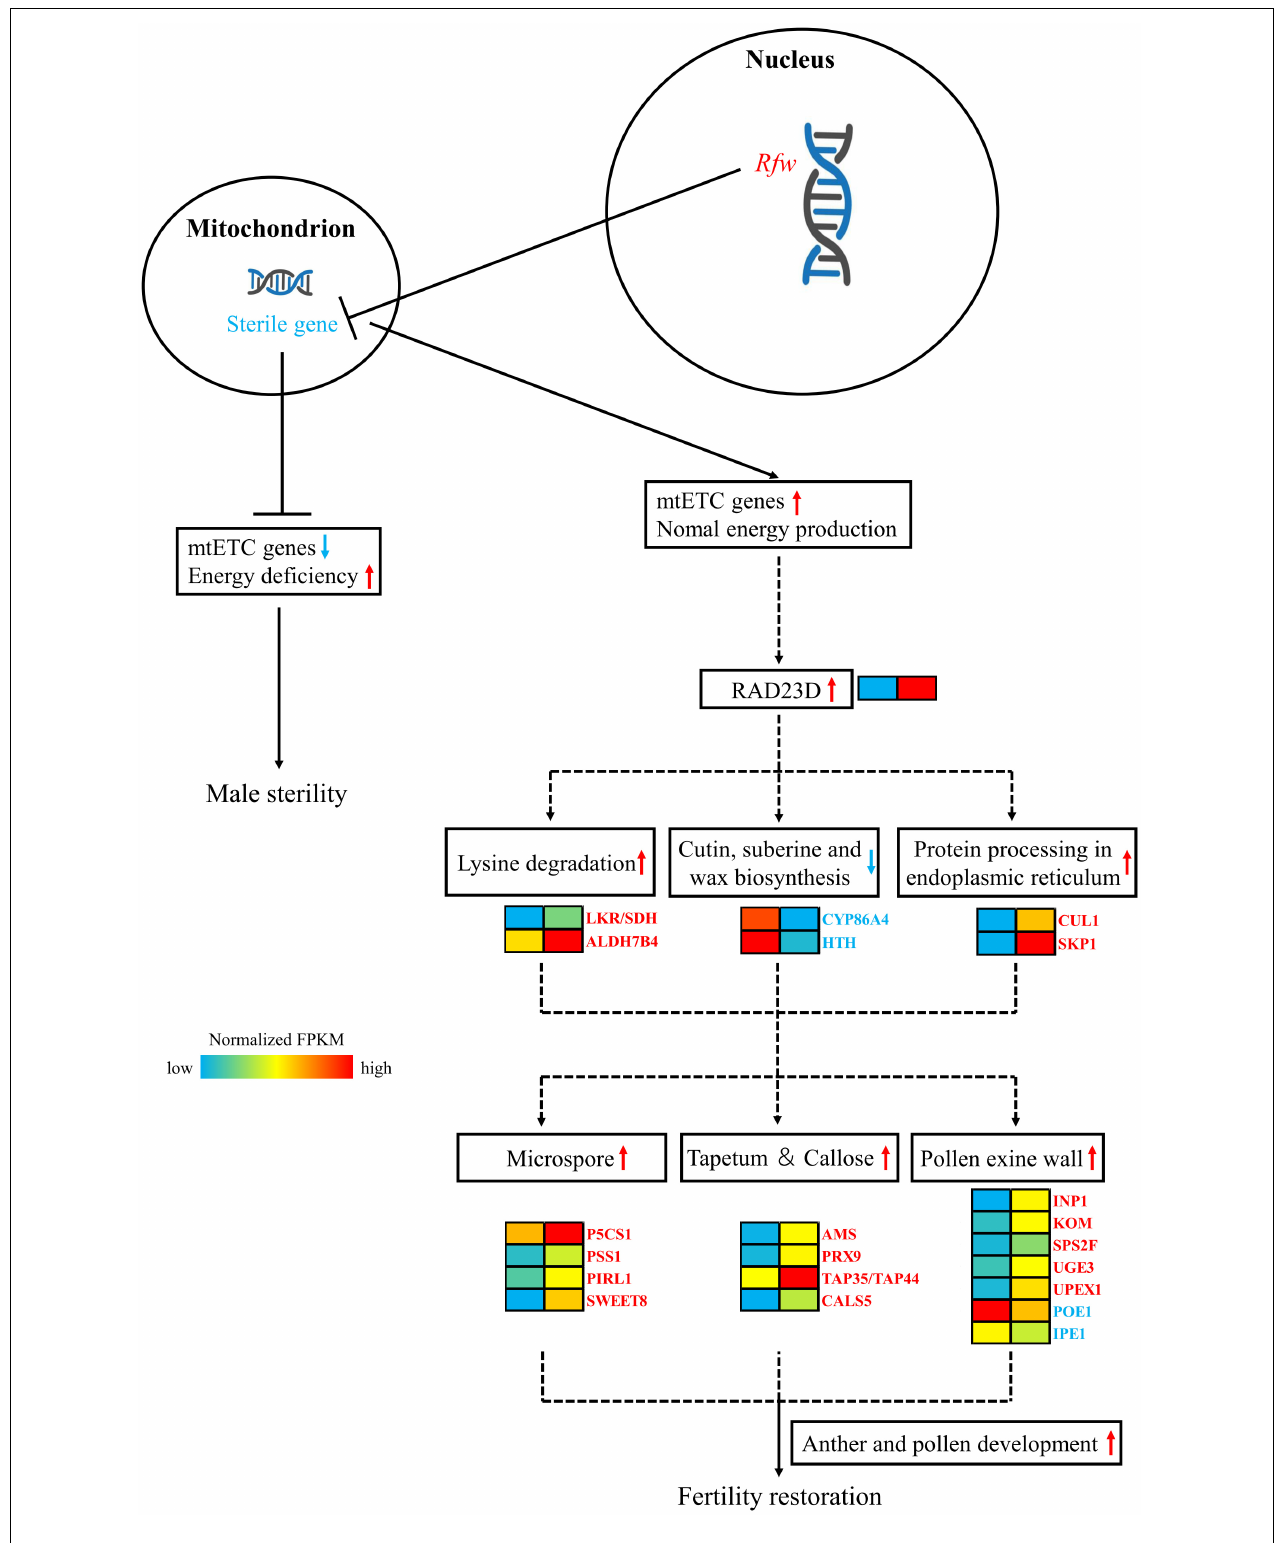
FIGURE 11 | Mechanistic model of the role of the sterile gene of WNJ01A CMS and the role of Rfw in fertility restoration. In the heat map, the left-hand side represents sterile buds and the right-hand side represents fertile buds.